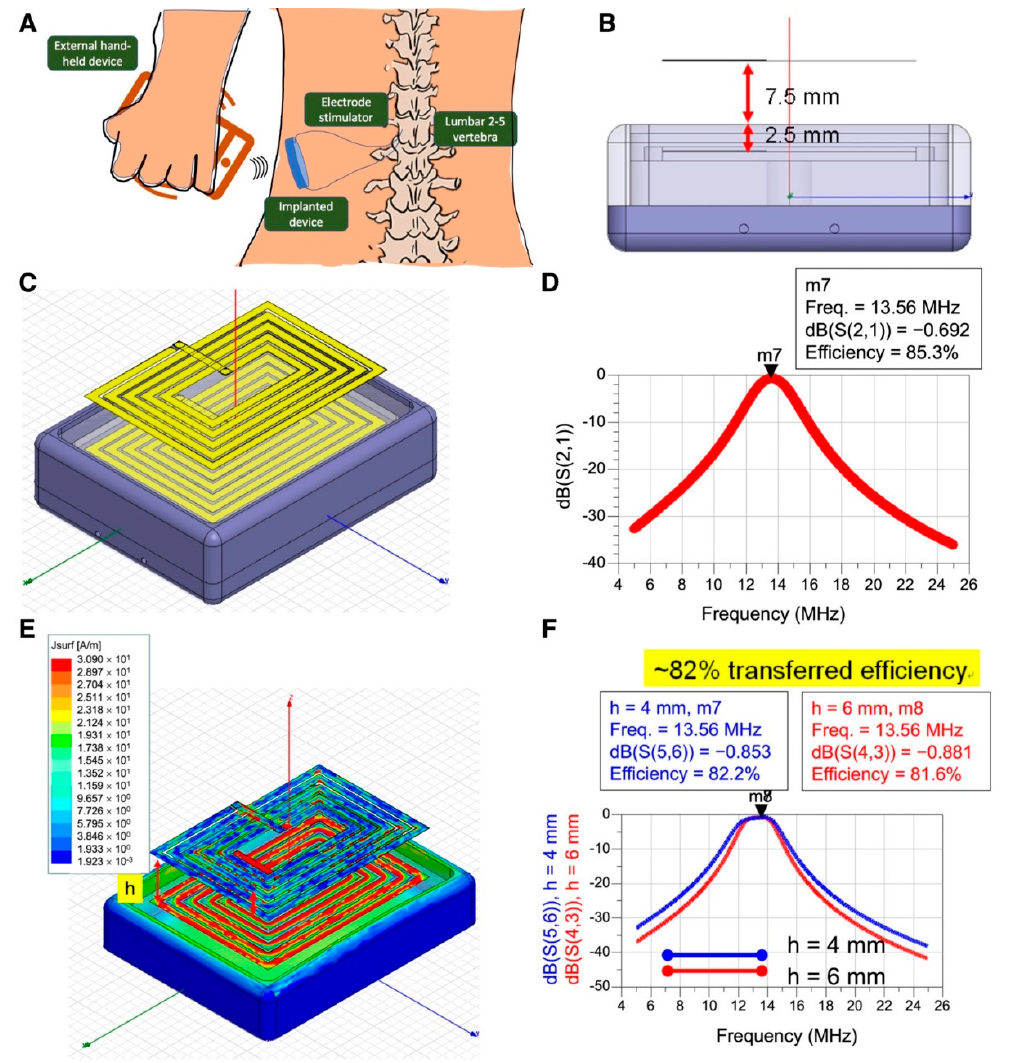
Figure 1. Rectangular-shaped wireless power transmission box and wire design. ( A ) Illustration of system model construction used in this 3D simulation for wireless energy transmission. ( B ) Transversal view of the rectangular device. The plane of the wires is placed 2.5 mm under the case cover, and the subcutaneous implantation depth is 7.5 mm. ( C ) Architecture design of cortex wires of the transmitter and receiver. ( D ) Simulated attenuation of wireless power transmission in various frequencies. ( E ) Current distribution in cortex wires in the receiver, and the distance between both cortex wires is set 10 mm. ( F ) Simulated attenuation of wireless energy transmission. The distance between box bottom to receiver’s wire loop is set 4 mm or 6 mm, respectively.